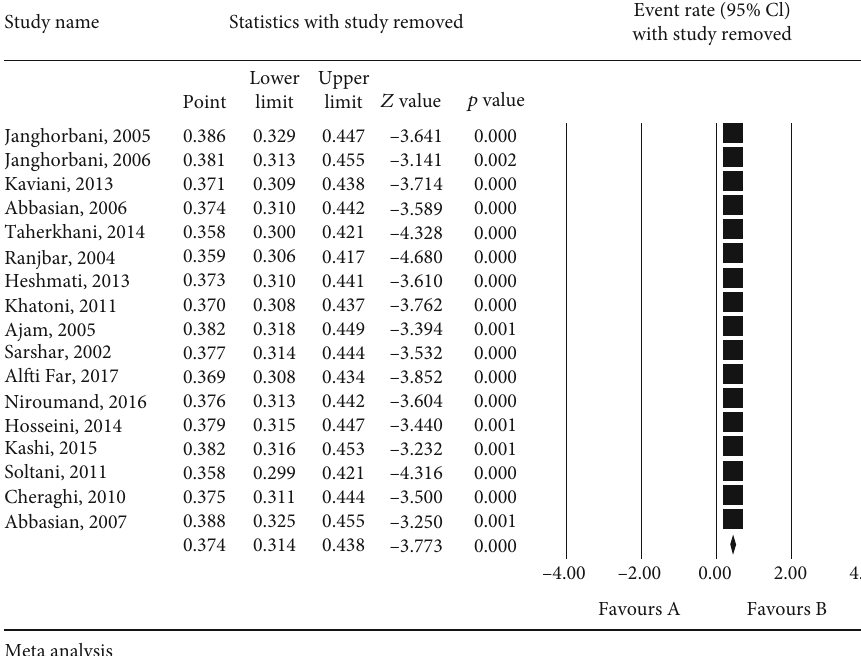
Figure 4: Sensitivity analysis results.